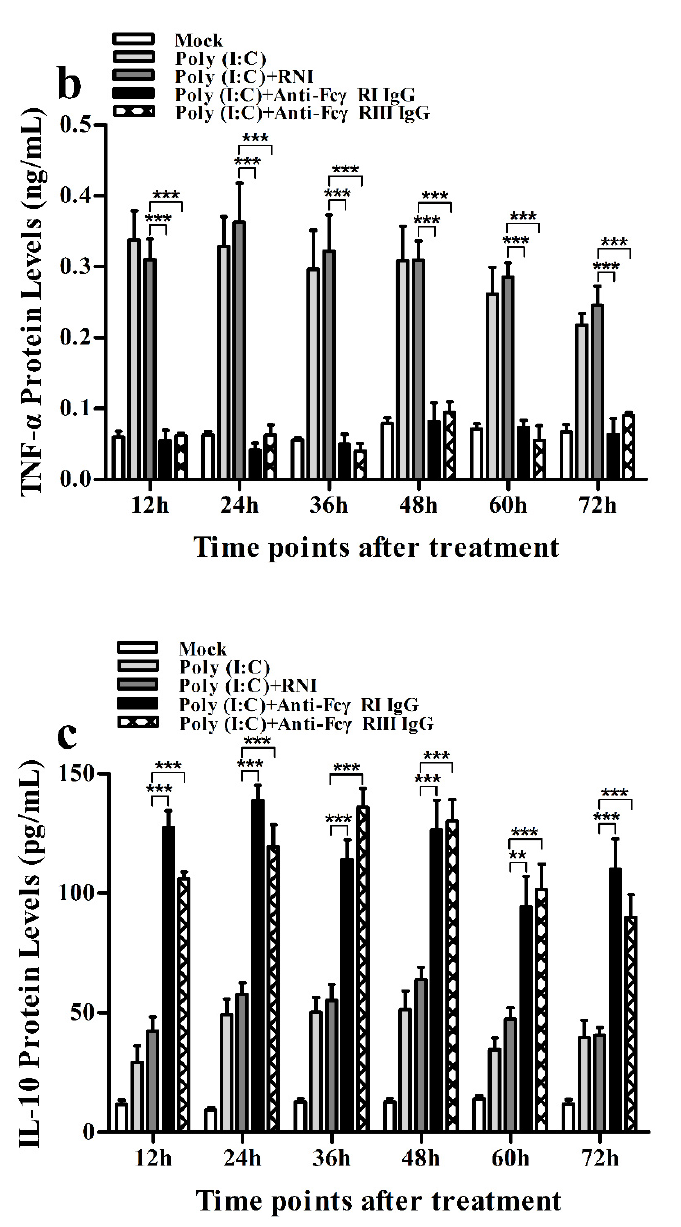
Figure 12. Effect of Fc γ RI or Fc γ RIII on poly (I:C)-induced protein expression of cytokines in porcine AMs. Cytokine protein levels in culture supernatants of poly (I:C)-stimulated cells pretreated with RNI, anti-Fc γ RI IgG or anti-Fc γ RIII IgG were detected by using ELISA Kits. ( a ) IFN- α protein level, ( b ) TNF- α protein level, ( c ) IL-10 protein level. *** p < 0.001, ** p < 0.01.